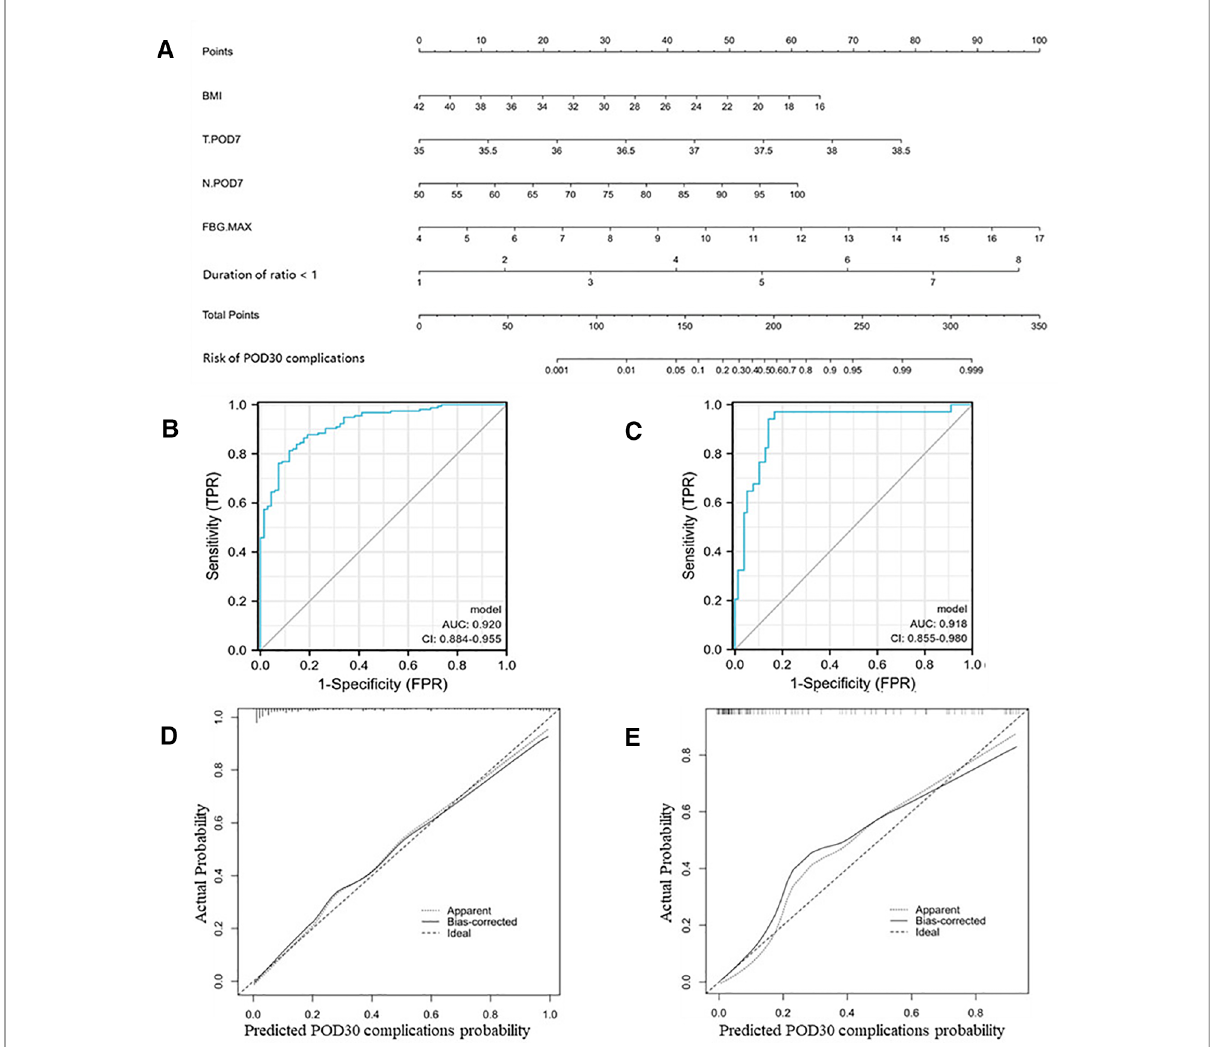
FIGURE 2 Nomogram-B and performance of the nomogram. ( A ) The possibility of POD30 complication was estimated by summing the scores corresponding to each risk factor. ROC and calibration curves of the nomogram for the probability of POD30 complication in the training set ( B,D ) and the validation set ( C,E ). In the calibration curve, the y -axis represents the probability of actual POD30 complication occurring and the x -axis represents the predicted probability. The wide dashed line represented a perfect prediction of the ideal model, and the solid line represented the actual performance of the Nomogram-B. The closer they were, the better the prediction